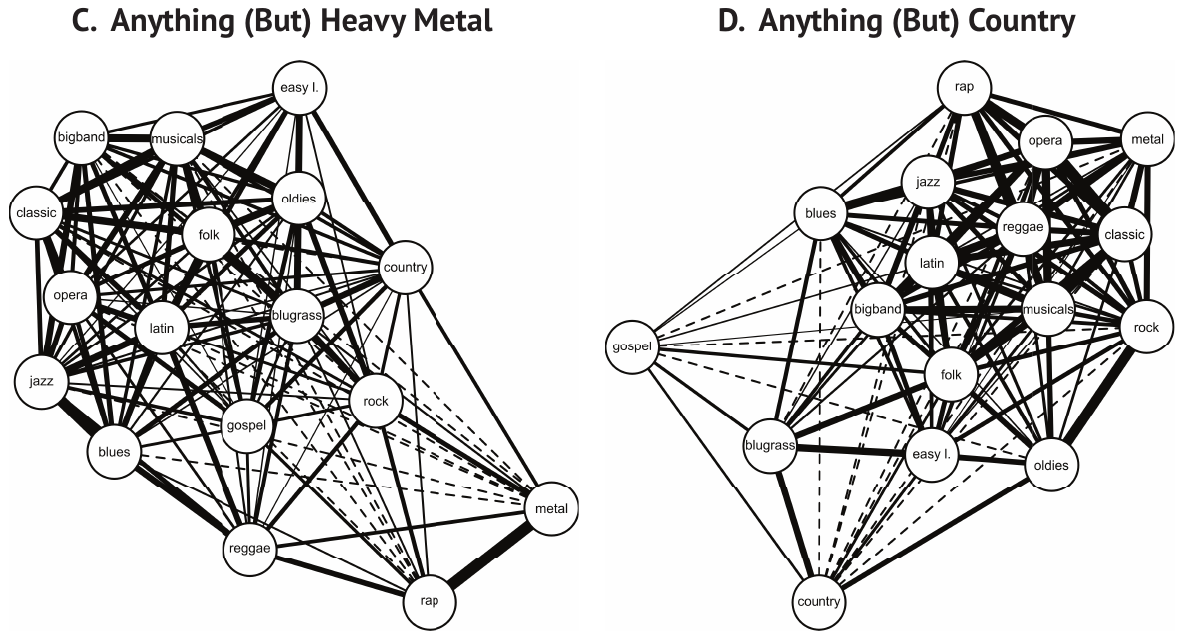
Figure10: Networks illustrate the four schematic classes identified by CCA. Ties represent correlations between genre tastes, with stronger correlations indicated by thicker lines. Negative correlations are depicted with dashed lines. Weak correlations ( | r | <0.05) are not